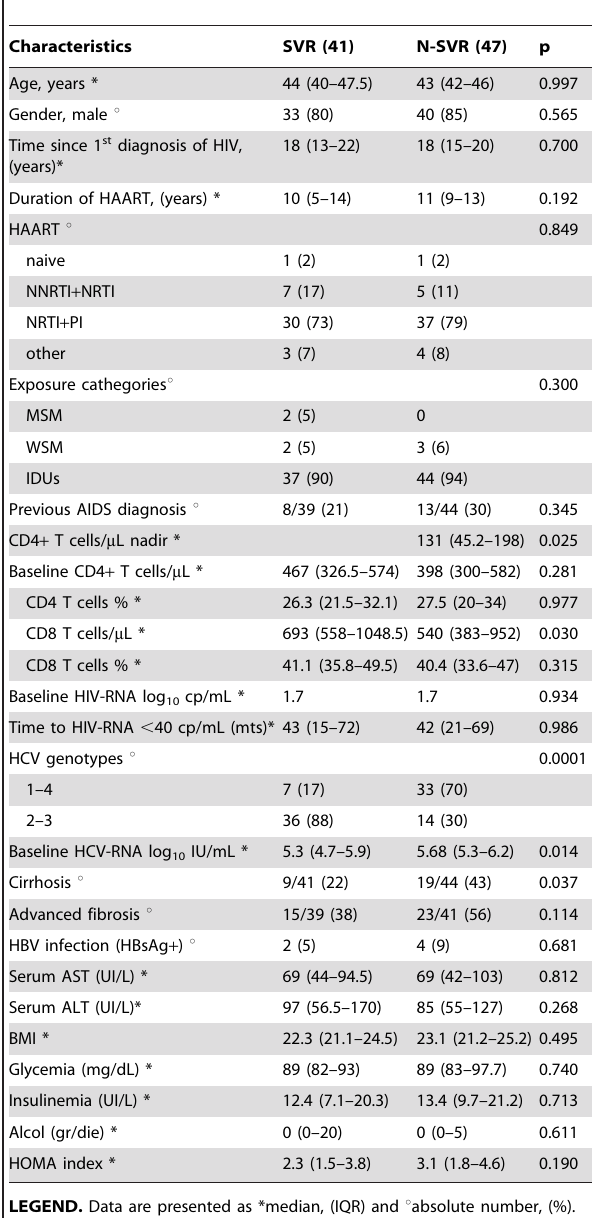
Table 2. Association between markers of microbial translocation and Early Virological Response to anti-HCV treatment.